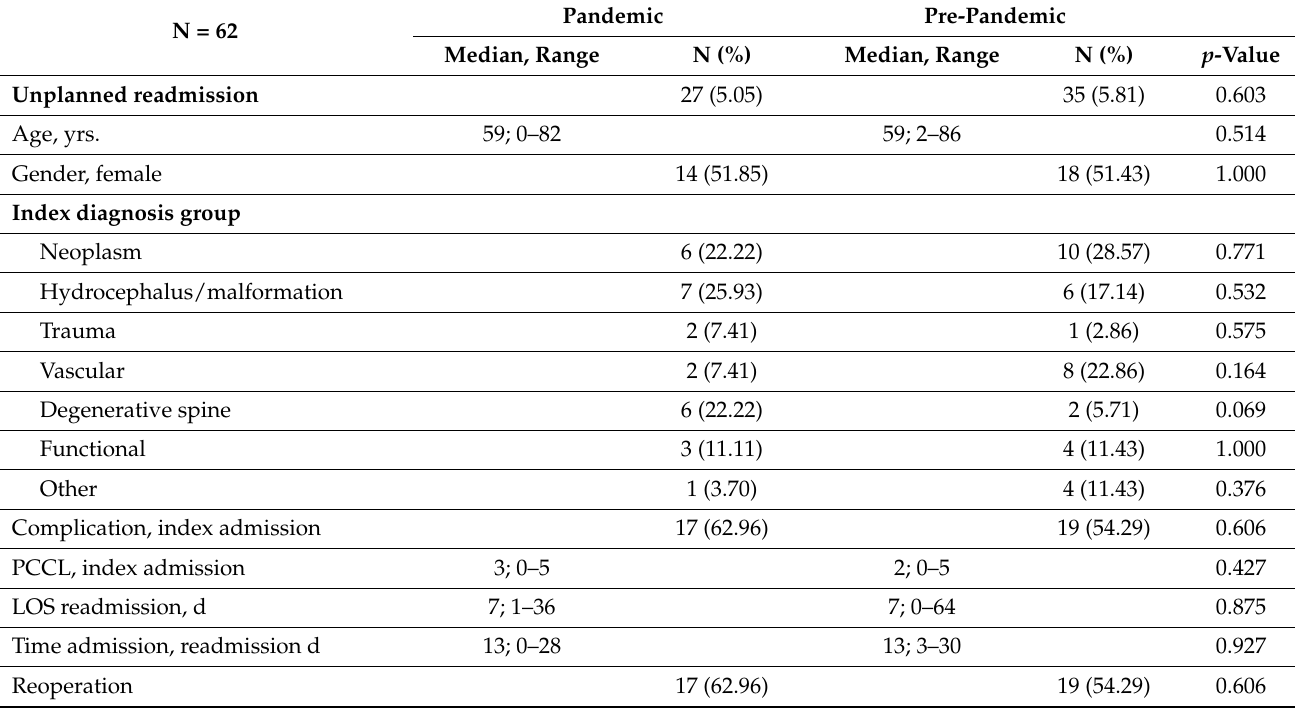
Table 3. Unplanned readmission in pandemic and pre-pandemic patient